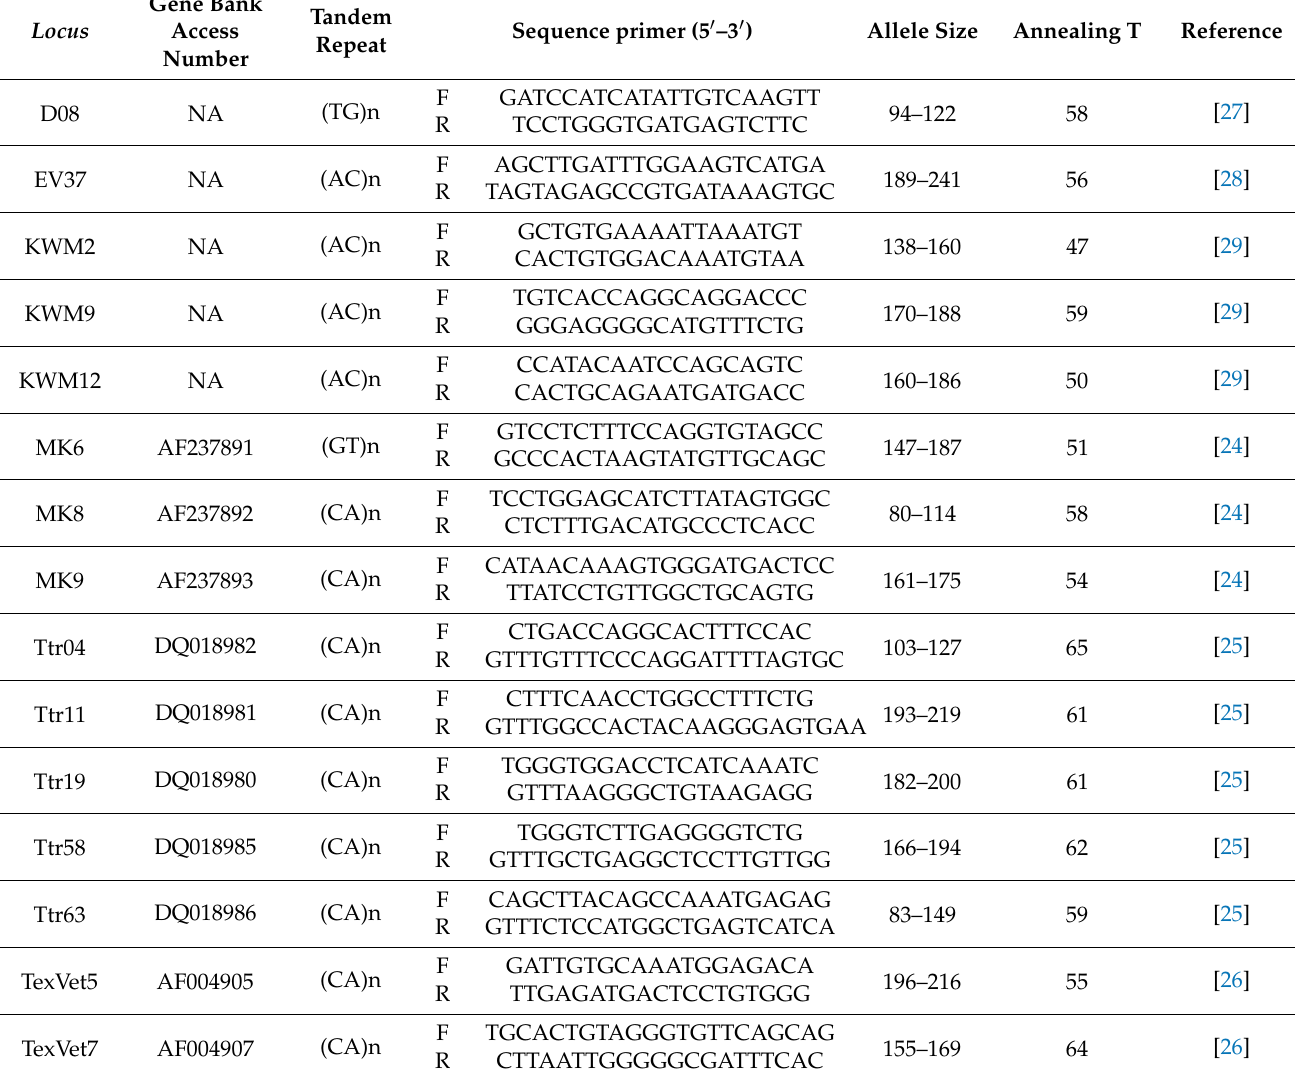
Table 1. Sequence of 15 loci explored in the four putative groups of T. truncatus